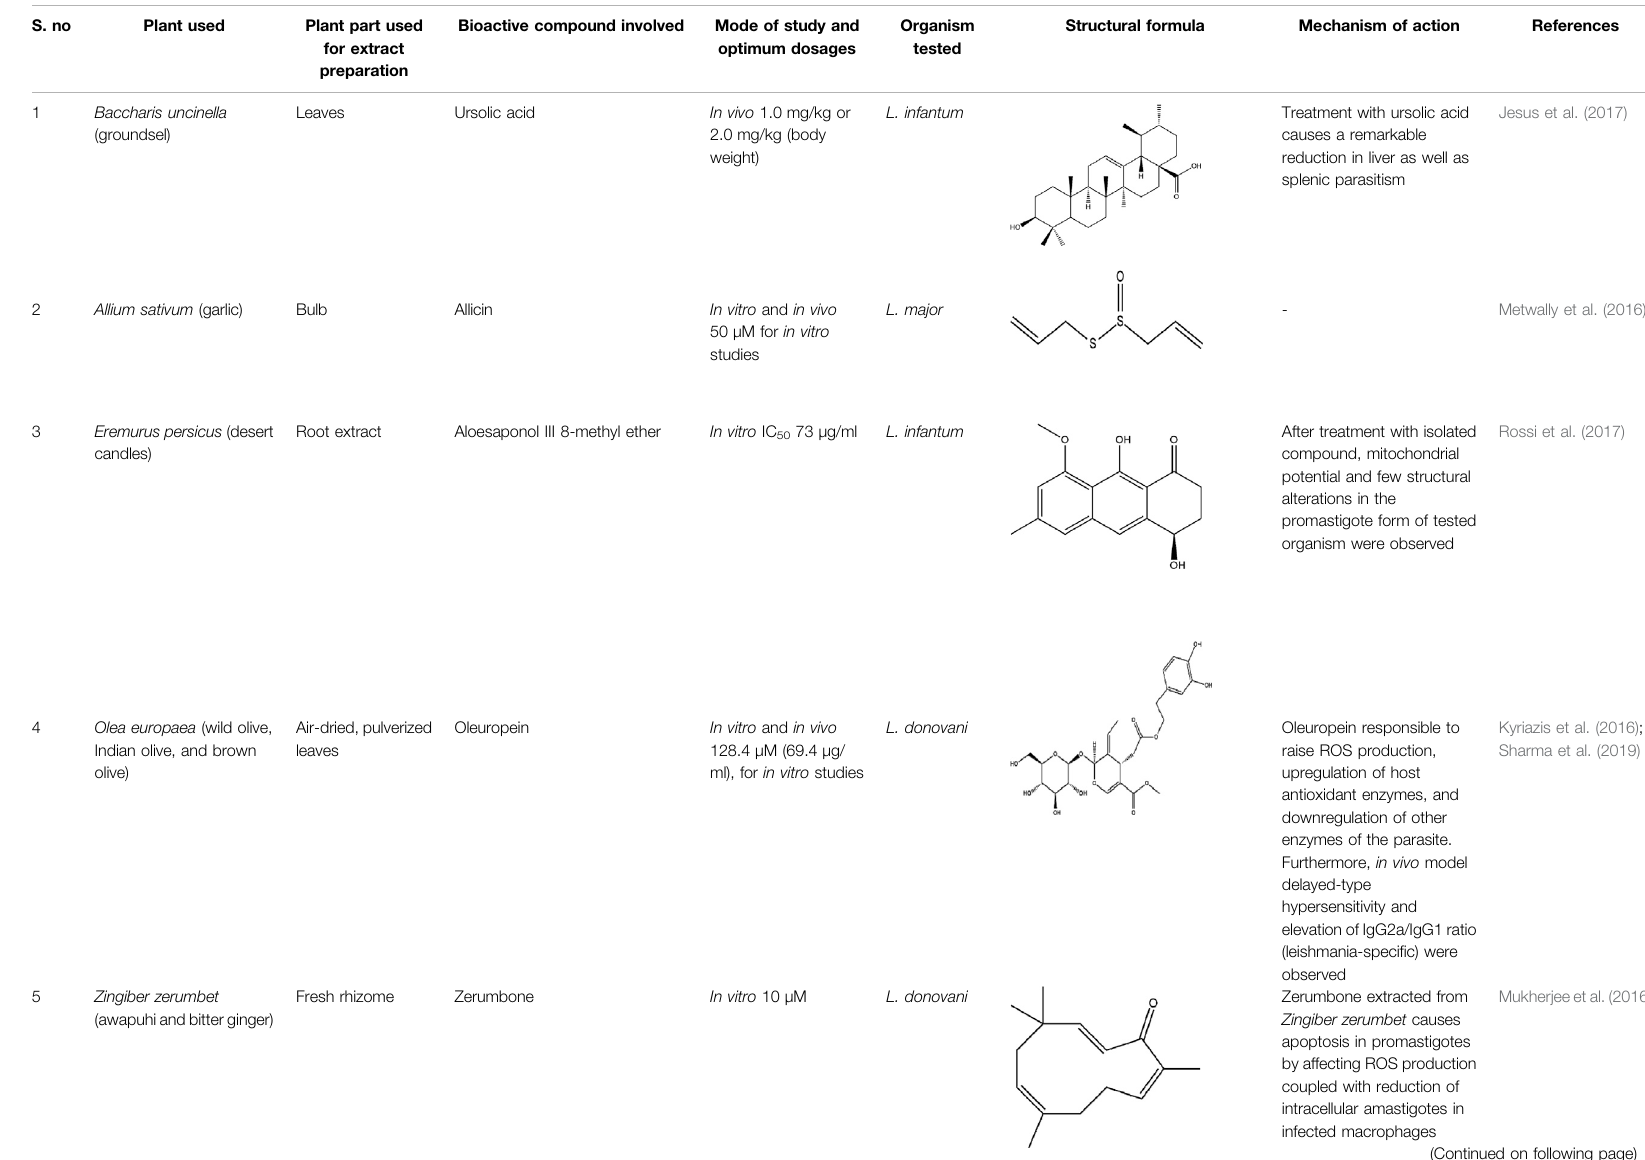
TABLE 1 | Role of plant-based natural products in the treatment of